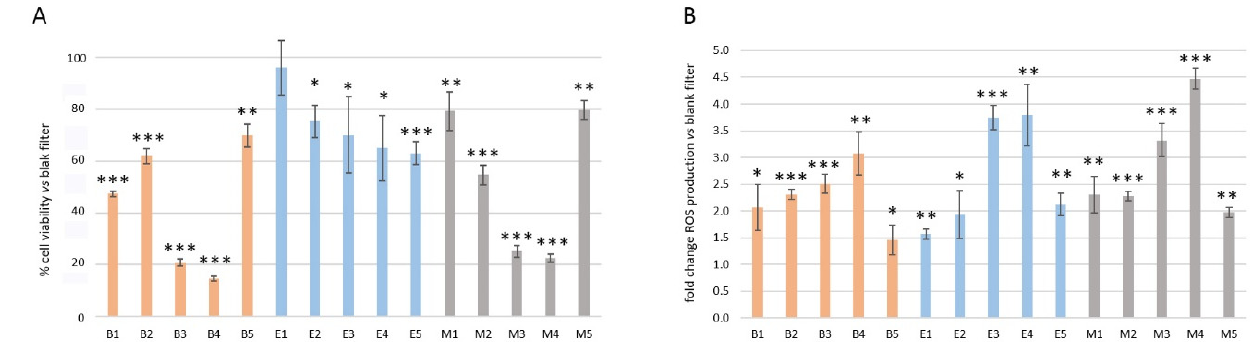
Figure 1. Cytotoxicity and induction of ROS by sample extracts incubated with A549 lung cancer cells. ( A ) Bar plot represents the percentage of cell viability after exposure to each of the sample extracts for 72 hours with respect to the samples exposed to blank samples. ( B ) Bar plot represents the fold change in ROS production after 2 h of cell exposure to each of the sample extracts with respect to cells exposed to blank extracts. Results are representative of n = 5 assays (cytotoxicity) and n = 3 assays (ROS) performed in triplicate; error bars indicate the standard deviation. Statistical significance was assessed by the T-test. p values: * <0.05; ** < 0.01, *** < 0.005.